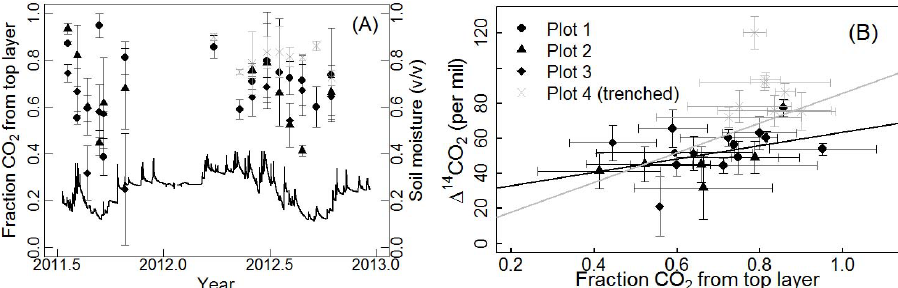
Fig. 7. Vertical partitioning, expressed as fraction of CO 2 produced in uppermost soil layer (top 7 to 8cm). Errors bars were calculated from Monte Carlo simulations to propagate uncertainties from gas well measurements. (A) variation in vertical partitioning through time, with soil water content shown for seasonal context, and (B) vertical partitioning versus 1 14 C of surface flux. The grey regression line includes plot 4 (slope p <0.01, R 2 = 0.29) and the black regression line excludes plot 4 (slope p = 0.07, R 2 = 0.19).